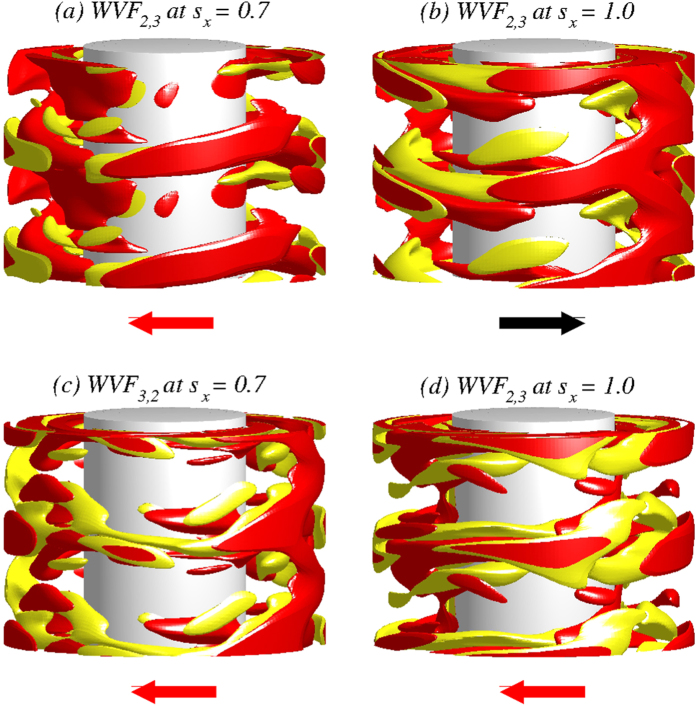
Flow structures in a transverse magnetic field.Isosurfaces of η for WVF2,3 and WVF3,2 for transverse magnetic field strength  and . Vorticity isosurfaces are  and two periods are plotted in the axial direction. The arrows below the snapshots illustrate the rotational direction (appearing laterally on the cylinders). For , the WVF2,3 flow is pro-grade but for , it is retrograded. The WVF3,2 flow is retrograde for both values of  (cf. Fig. 5). See also movie files movie5.avi, movie6.avi and movie7.avi in SMs.